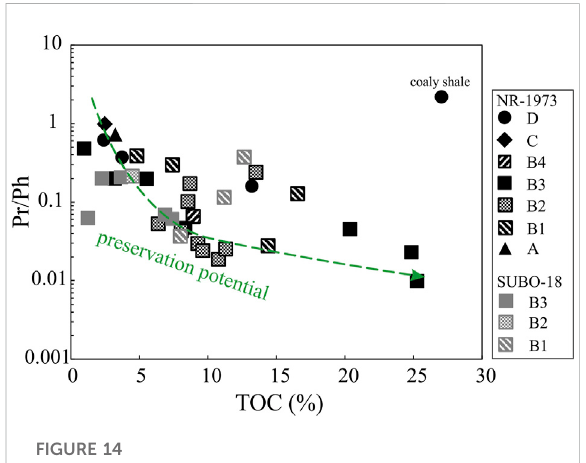
FIGURE 14 Crossplot of Pr/Ph vs TOC of the post-impact sediments in the Nördlinger Ries. Pr=pristane, Py=phytane, TOC=total organic carbon content. See Figure 2 for stratigraphic